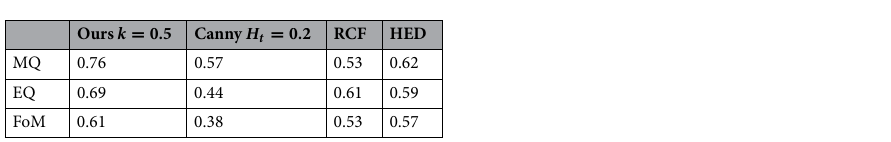
Table 3. Performance Comparison using BSDS500 dataset, d 0